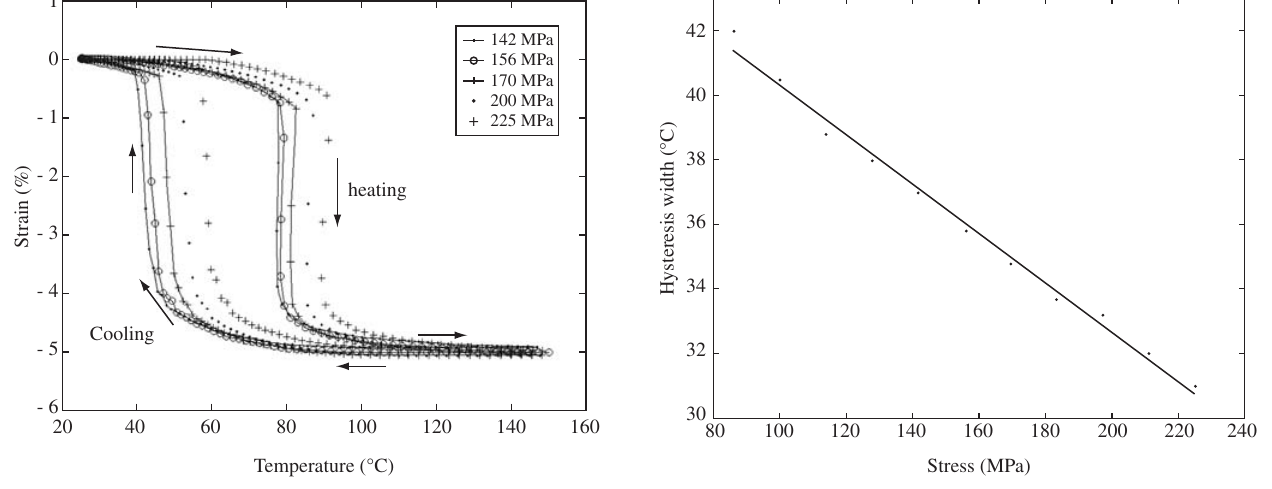
Figure 8. Hysteresis width as a function of applied load on the SMA wire.